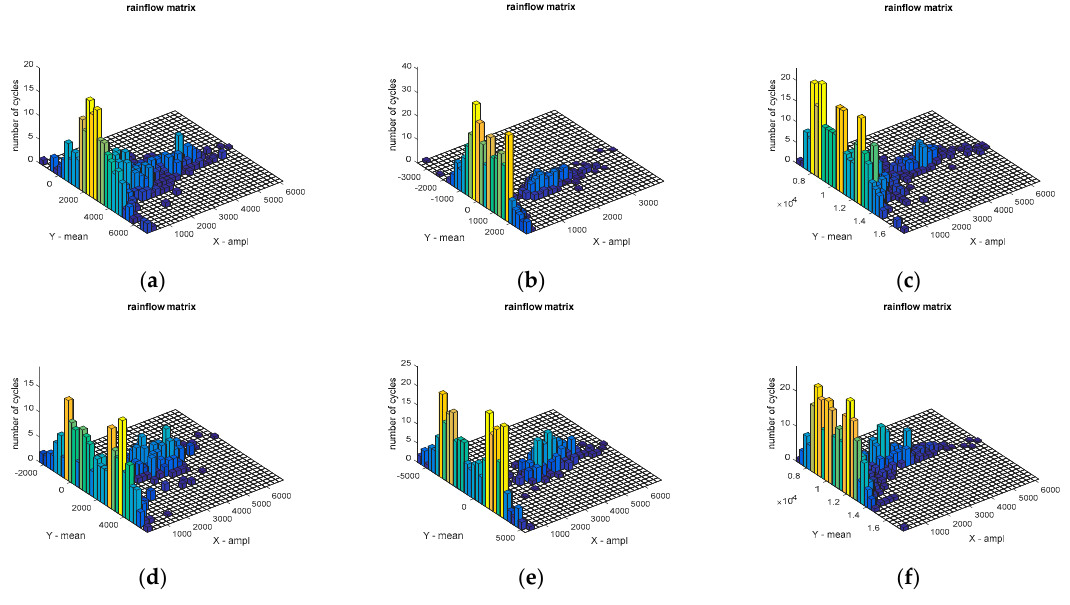
Figure 10. Rain flow matrix of load on the target road. ( a ) Rain flow matrix of F x on the left WFS, ( b ) Rain flow matrix of F y on the left WFS, ( c ) Rain flow matrix of F z on the left WFS, ( d ) Rain flow matrix of F x on the right WFS, ( e ) Rain flow matrix of F y on the right WFS, ( f ) Rain flow matrix of F z on the right WFS.